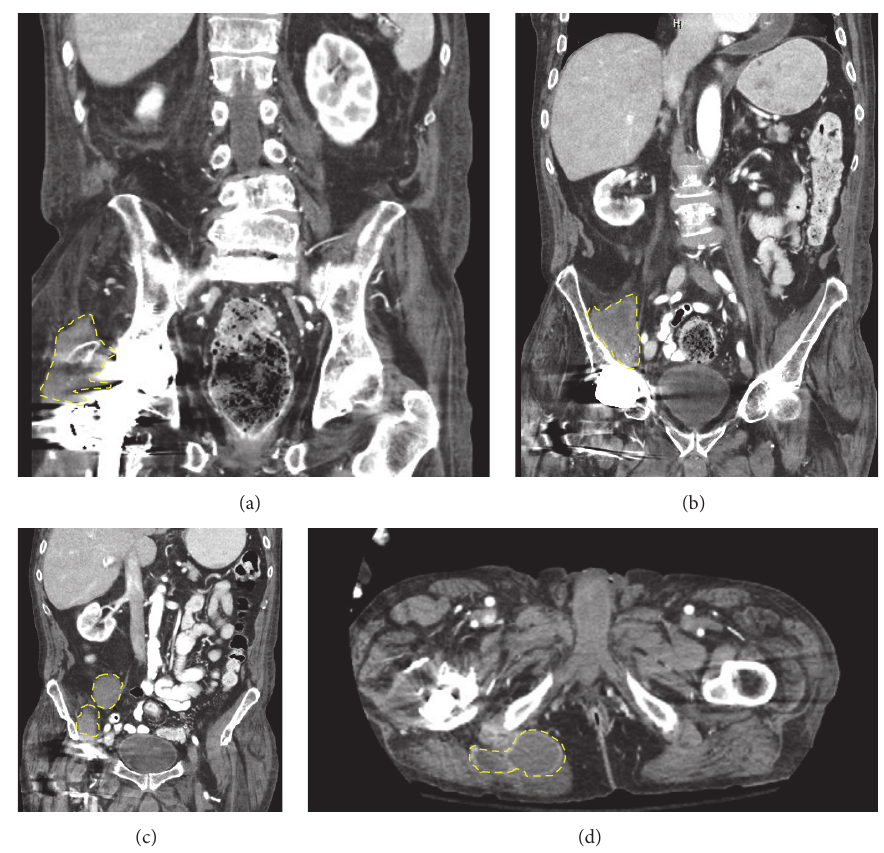
Figure 1: CT abdomen. (a) Coronal cross section demonstrating a right hip complex fluid collection. (b) Right posterior iliac fossa fluid collection. (c) Right anterior iliac fossa fluid collections. (d) Transverse section demonstrating right buttock fluid